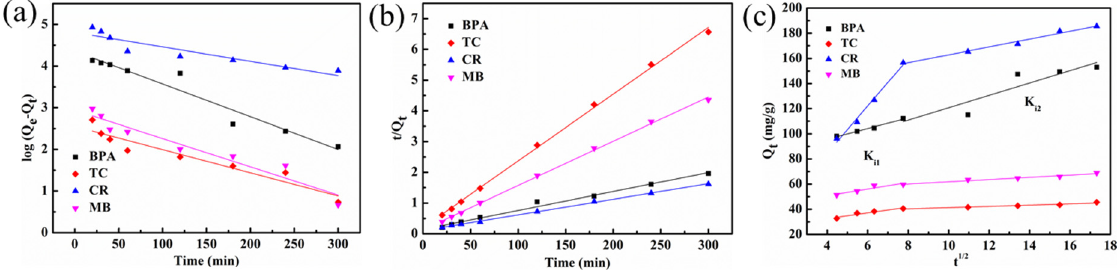
Figure 5. Fit of kinetic data to ( a ) the pseudo-first-order model, ( b ) the pseudo-second-order model, and ( c ) the intraparticle diffusion model on BPA, TC, CR, and MB. Table 2. Parameters of Pseudo-First-Order, Pseudo-Second-Order, and Intraparticle Diffusion Models. Kinetics